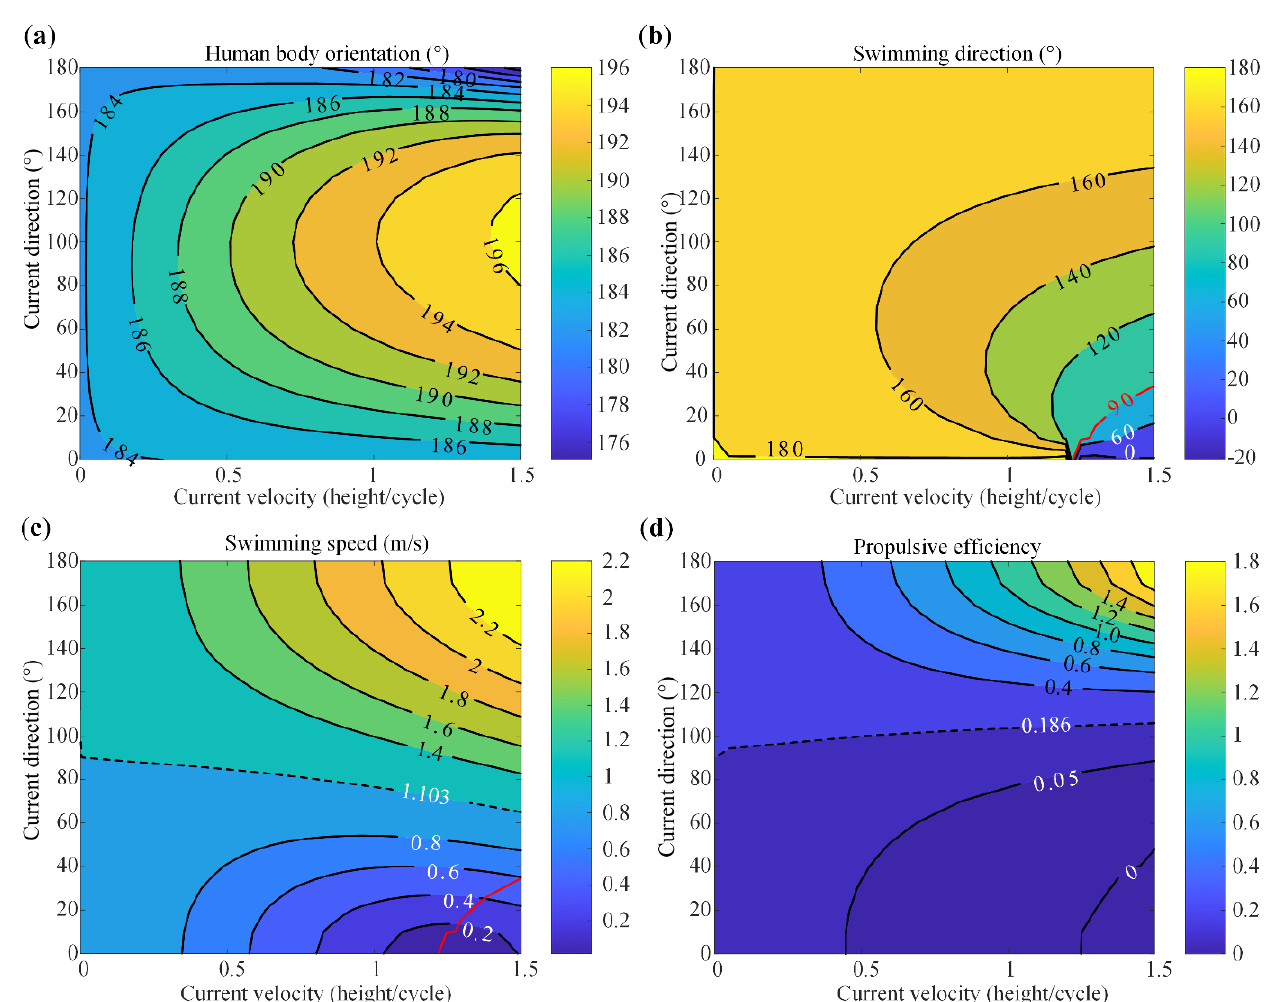
Figure 6. Parametric analysis results of the effects of currents on freestyle swimming performance. Contour plots of ( a ) human body orientation, ( b ) swimming direction, ( c ) swimming speed, and ( d ) propulsive efficiency are provided. The red curve in ( b , c ) denotes the current conditions under which the human swims along the y direction. The dashed curve in ( c ) denotes the swimming speed in still water, and the dashed curve in ( d ) denotes the propulsive efficiency in still water.